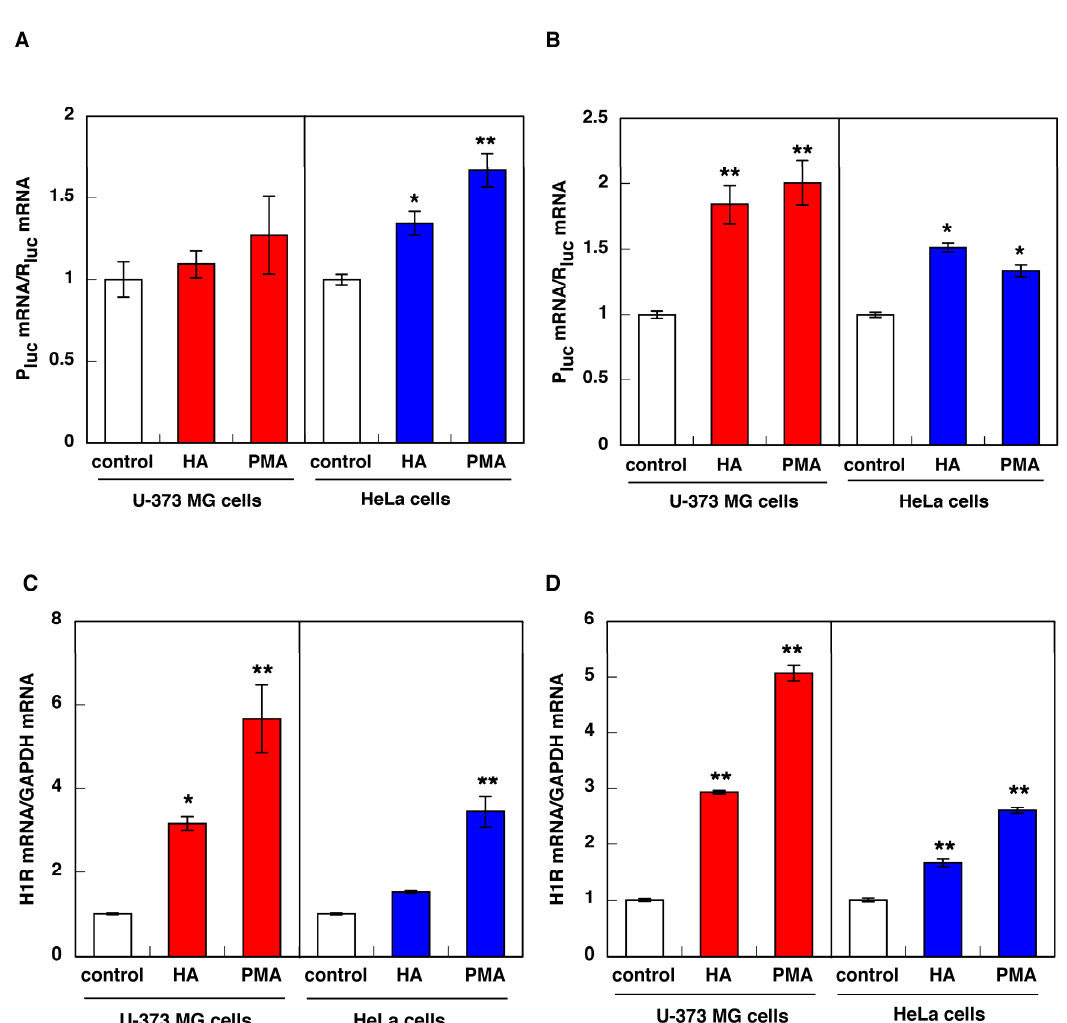
Figure 6. Activation of the promoter of H/I/K splice variant ( A , C ) or B/K splice variant ( B , D ) by histamine and/or PMA stimulation in U-373 MG cells and HeLa cells. Cells were transfected with the human H1R reporter plasmid containing the putative promoter region of H/I/K splice variant ( A , C ) or B/K splice variant ( B , D ) for 12 h. Then, the cells were starved in serum-free medium for 24 h before treatment with 100 µ M (U-373 MG cells) or 10 µ M (HeLa cells) histamine (HA) or 100 nM PMA. Luciferase mRNA ( A , B ) and H1R mRNA ( C , D ) was determined by quantitative RT-PCR 2 h (U-373 MG cells) or 3 h (HeLa cells) after histamine/PMA treatment. Data are expressed as means ± SEM ( n = 6). ** p < 0.01, * p < 0.05 vs. control. For statistical analysis, one-way ANOVA with Tukey–Kramer’s test was